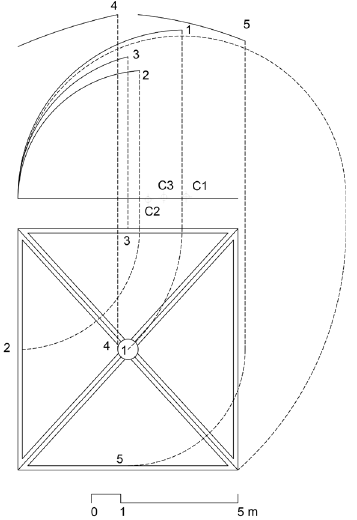
Figure 15 . Schematisation of the geometries of one of the vaults of Santa Lucia.